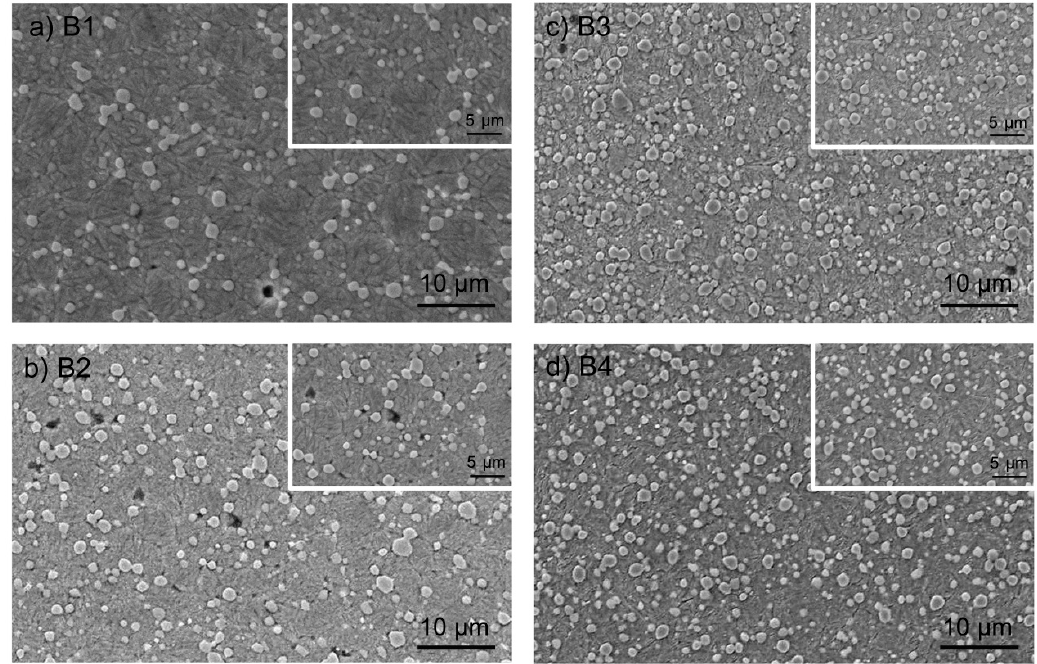
Figure 5. Microstructures of grade B steel after conventional heat treatments: ( a ) B1: 2 min of austenitization at temperature T A = 1180 °C and 3 x 2 h tempering at temperature T T = 540 °C; ( c ) B3: 6 min of austenitization at temperature T A = 1050 °C and 3 × 2 h tempering at temperature T T = 600 °C; and heat treatment procedures with deep cryogenic treatment: ( b ) B2: 2 min of austenitization at temperature T A = 1180 °C, 24 h of DCT at temperature T DCT = − 196 °C and 2 h tempering at temperature T T = 540 °C; ( d ) B4: 6 min of austenitization at temperature T A = 1050 °C, 24 h of DCT at temperature T DCT = − 196 °C and 2 h tempering at temperature T T = 600 °C.